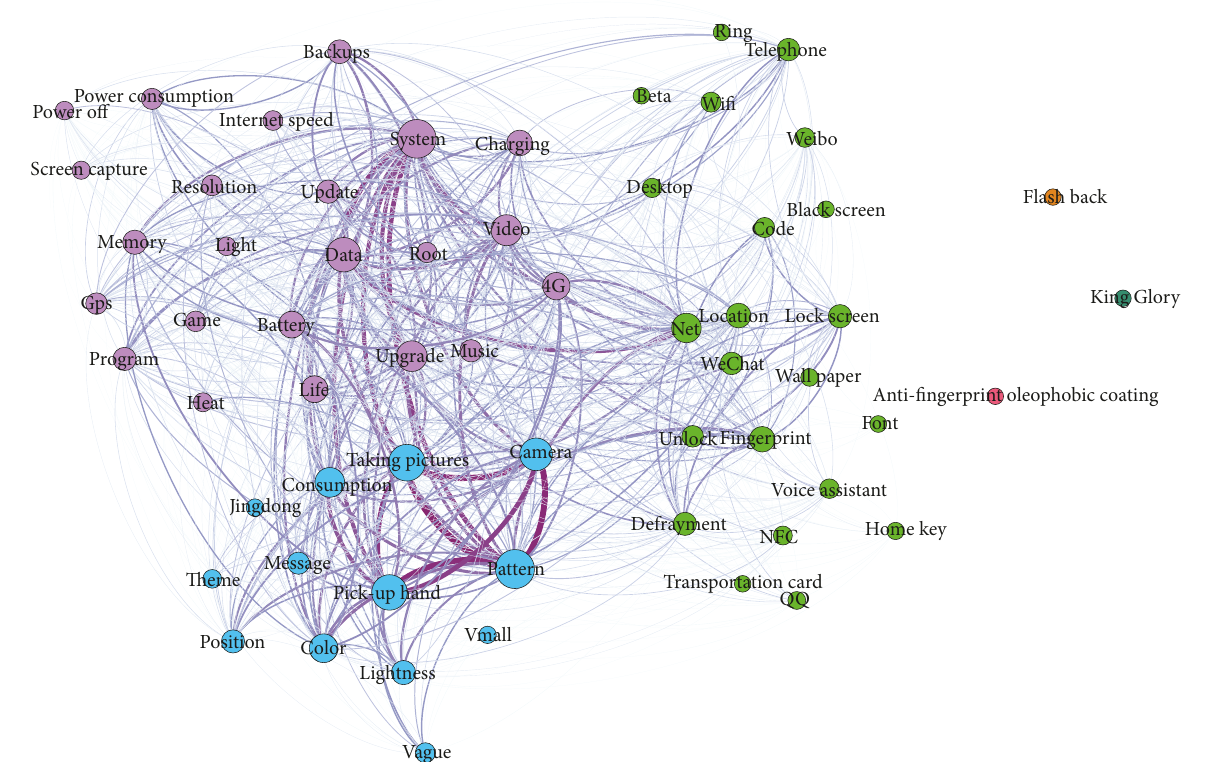
Figure 5: EUG interaction